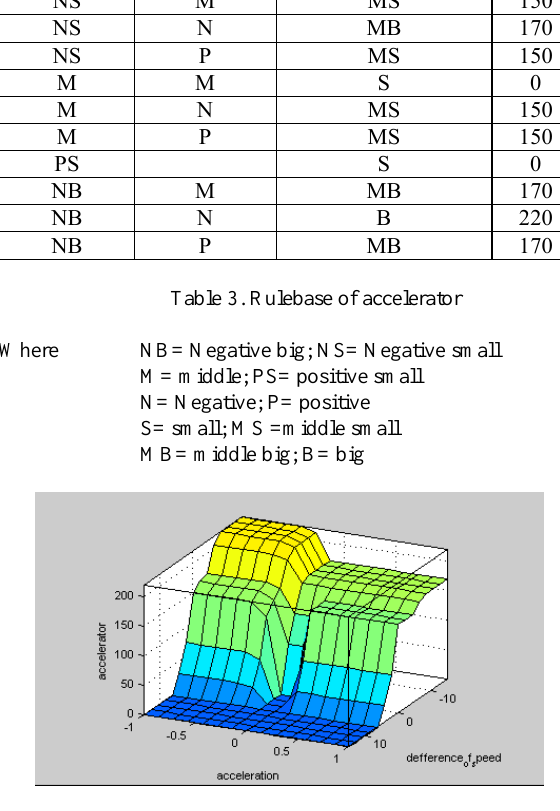
Figure 10. Output data of brake